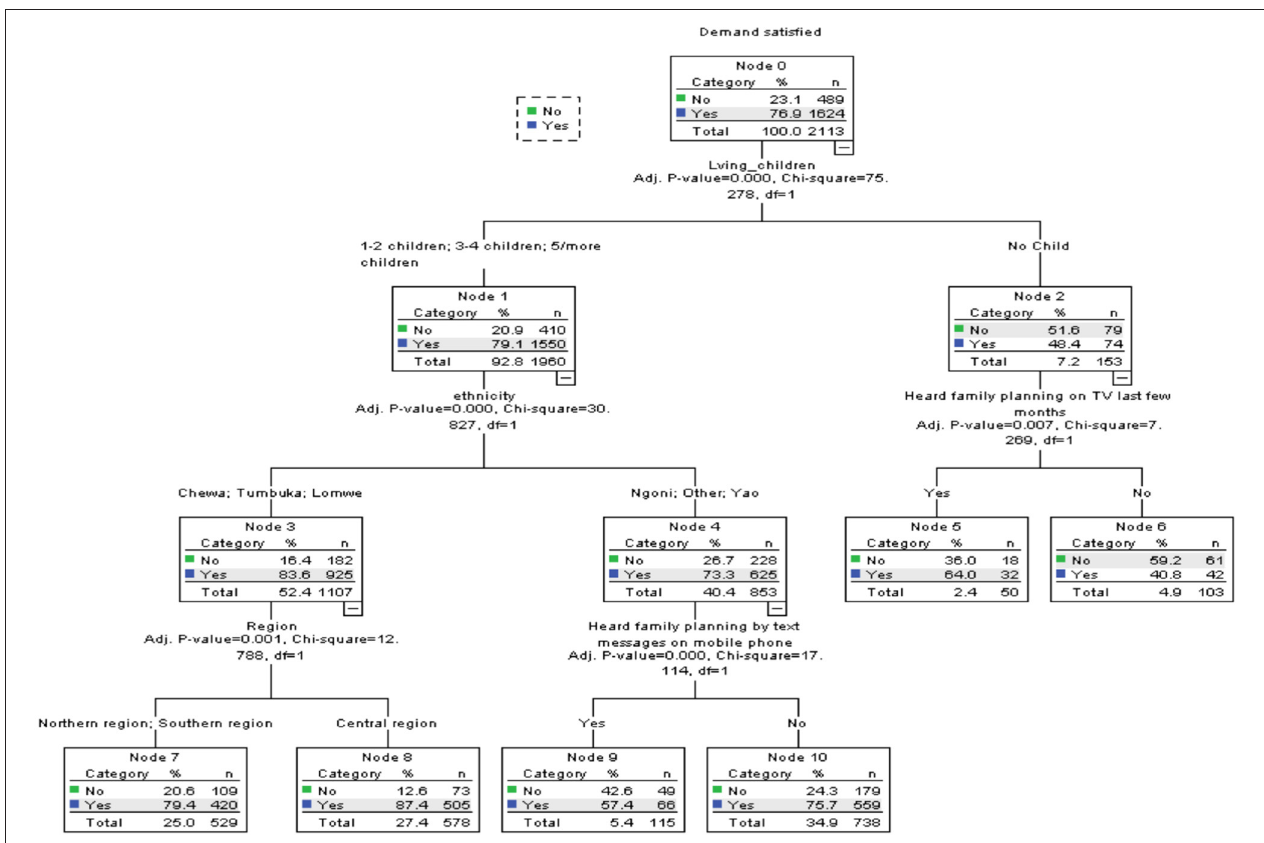
FIGURE 1 | Decision tree diagram for all urban women with demand for modern methods in Malawi. Node 2: Women With No